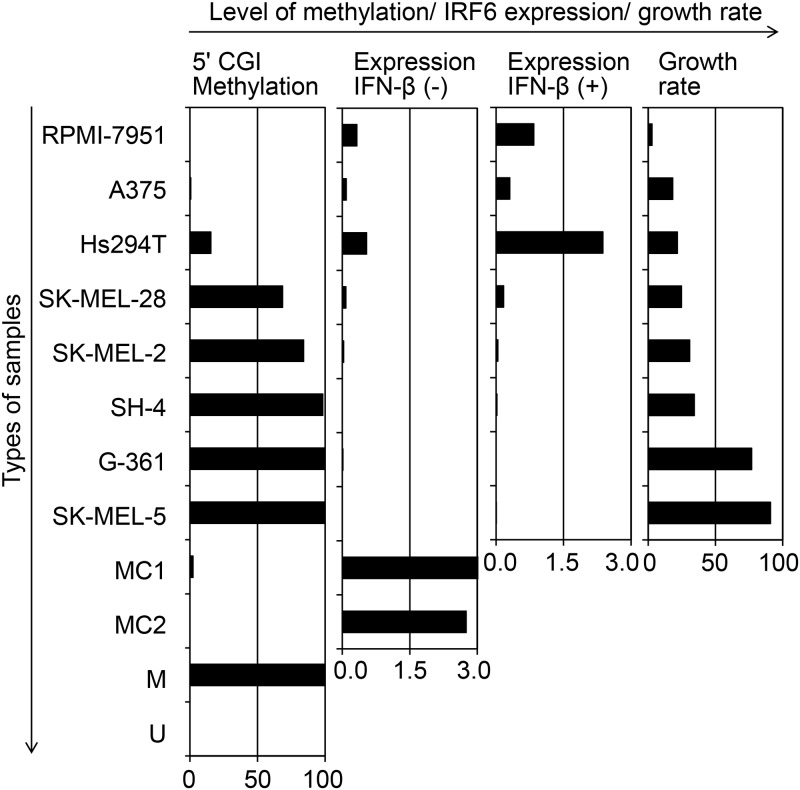
Concordance of the methylation status of the 5' IRF6 CGI with IRF6 transcription or IFN-β sensitivity in melanocyte-lineage cells.The left bar graph indicates the methylation levels (%) of the 5' IRF6 CGI in the indicated melanoma cell lines, normal cultured melanocytes (MC1 and MC2) and controls including methylated DNA (M) and unmethylated DNA (U). The second bar graph from the left indicates the expression levels of IRF6 divided by the expression levels of GAPDH (×10−4) in each of the melanoma cell lines and normal cultured melanocytes (MC1 and MC2) that were not treated with IFN-β. The expression level of MC1 was 1.1×10−3, which is higher than the 3.0×10−4 upper limit of the graph. The third bar graph from the left indicates the expression levels of IRF6 divided by the expression levels of GAPDH (×10−4) in each of the melanoma cell lines treated with IFN-β. The fourth bar graph from the left indicates the cell growth rate which was defined as the value of the number of IFN-β-treated cells divided by the number of PBS-treated cells. All four bar graphs correspond to each other with respect to the melanoma cell lines and normal cultured melanocytes.